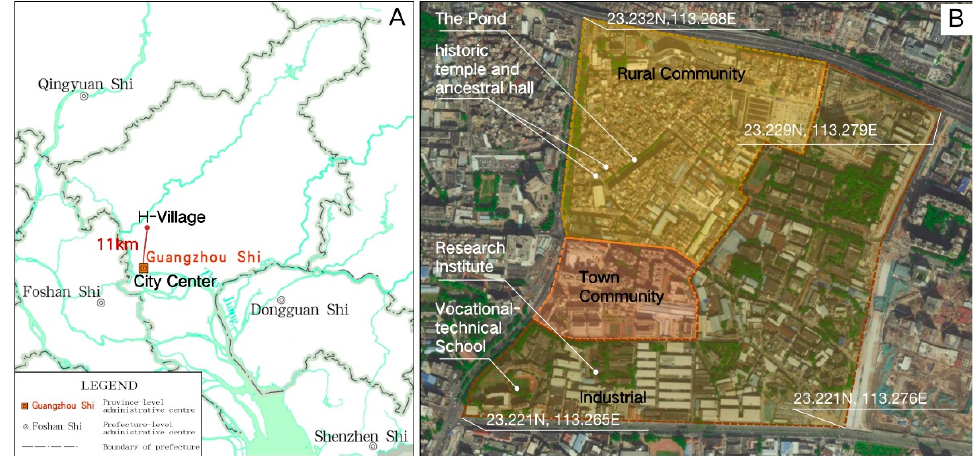
Figure 9. Location and current situation of H-Village (( A ) showing the location of H-Village, 11 km north of the city center, and ( B ) showing the current situation of H-Village, consisting of rural, town, and industrial communities, with some reserved buildings and landscape in the area).